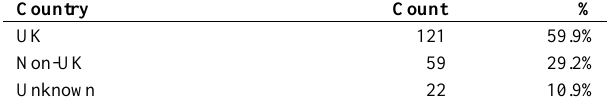
Table 1. Participant’s inferred country of work